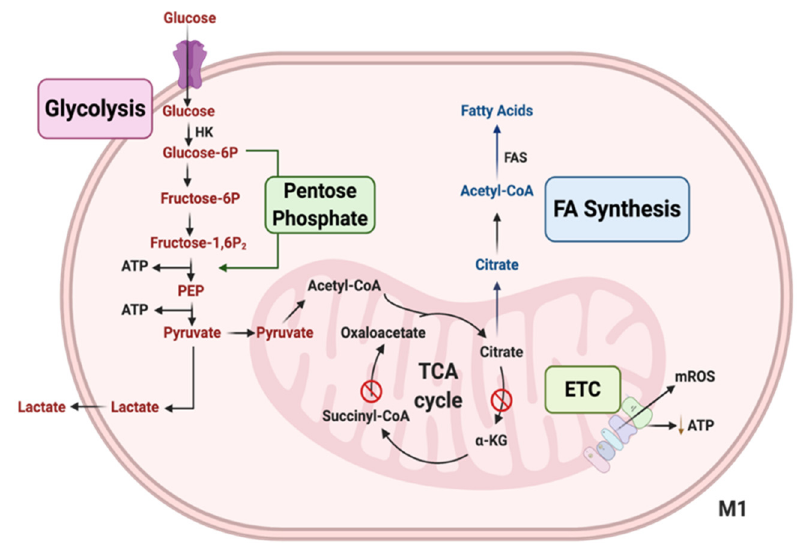
Figure 3. Important metabolic pathways in M1 Macs. M1 Macs have increased aerobic glycolysis, the process of converting glucose into lactate. An increased pentose phosphate pathway (PPP) is another characteristic of M1 Macs, which leads to the generation of the inflammatory mediators, nitric oxide (NO) and reactive oxygen species (ROS). M1 Macs have enhanced levels of succinate and citrate because the TCA cycle is partially inhibited. Furthermore, increased citrate leads to enhanced fatty acid synthesis (FAS) in M1 Macs. Reduced levels of electron transport chain (ETC) activity and production of mitochondrial ROS are also known hallmark features of M1 Macs.